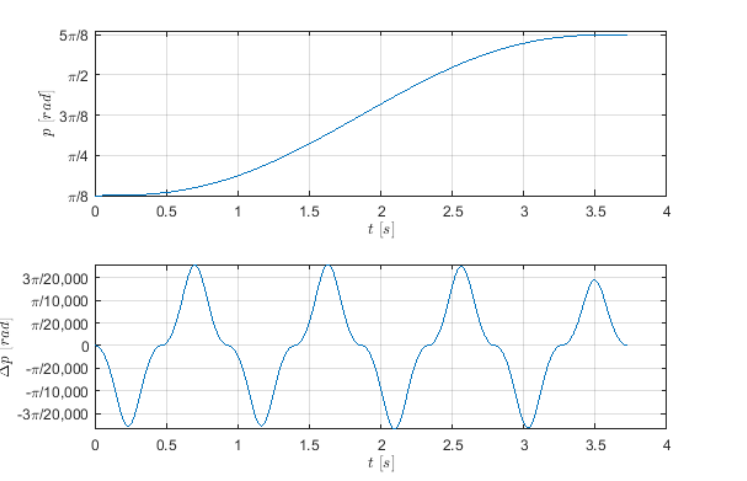
Figure 5. Trajectory parameter p behaviour (upper part) for the 16 f N − 1 time interval and its invariant control modification ∆ p (bottom